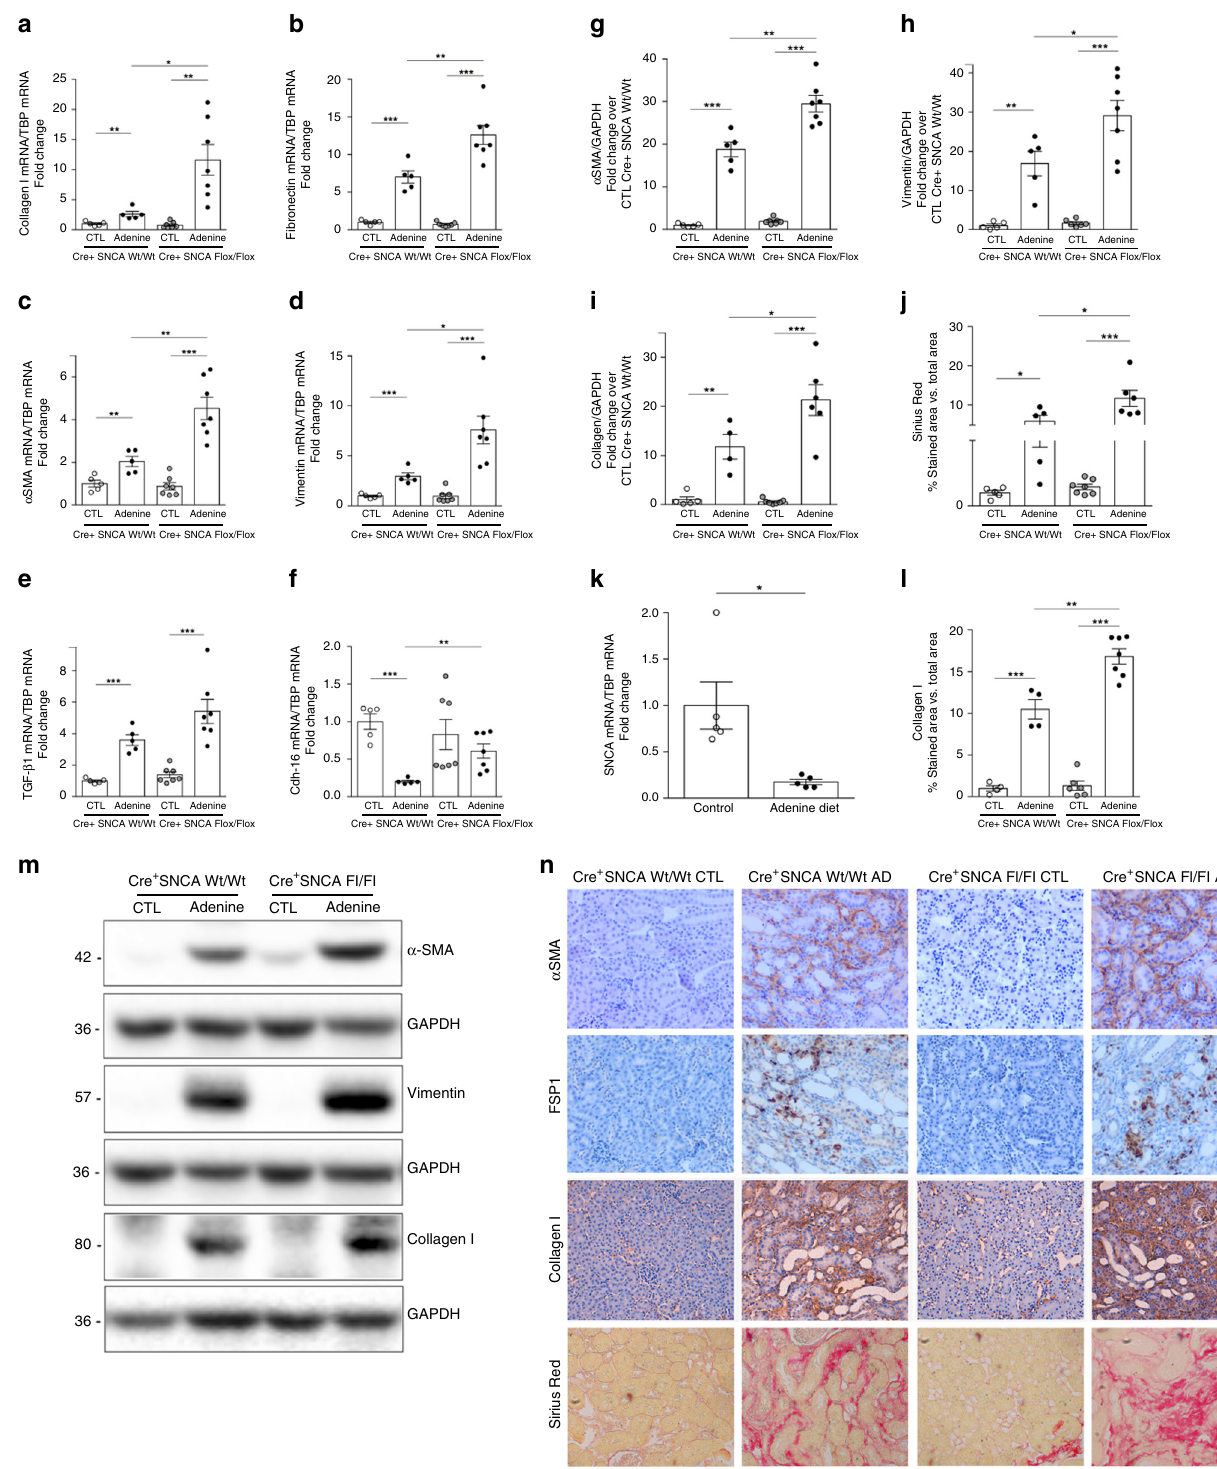
Fig. 8 RPTEC-SNCA deletion aggravates adenine-induced renal fi brosis. a – f , k Total mRNA was extracted from kidneys of PEPCK Cre + SNCA wt/wt and PEPCK Cre + SNCA fl / fl mice fed a regular or adenine rich diet for 4 weeks. mRNA levels of collagen I, fi bronectin, α -SMA, vimentin, TGF- β 1, cadherin-16 and SNCA were determined by quantitative real-time PCR and normalized to TBP. m Whole kidney lysates were processed for protein analysis and were immunoblotted with antibodies against α -SMA, vimentin, collagen I and GAPDH. m Representative Western blot analysis and g – i quantitative analysis by densitometry. j , l Quanti fi cation of collagen deposition in kidneys of PEPCK Cre + SNCA wt/wt and PEPCK Cre + SNCA fl / fl mice after Sirius red staining ( j ) and immunohistochemistry for collagen I ( l ) was expressed as a positive stained area vs. total analyzed area. Data are presented as mean ± SEM ( n = 5 – 7 mice/group). * p < 0.05, ** p < 0.01, *** p < 0.001. The p -value by two-way ANOVA. n Representative images of Sirius red staining and immunohistochemistry for α -SMA, FSP1 and collagen I in mouse kidneys. Scale bar represents 50 µ m. Source data are provided as a Source Data fi